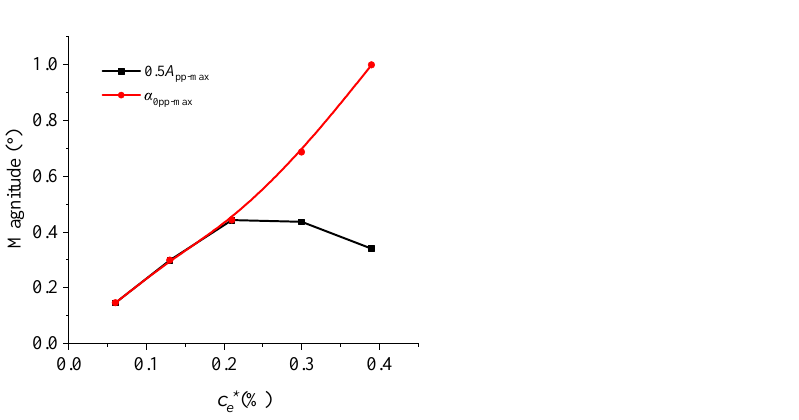
Figure 16. Half of the peak-to-peak value and average opening of the fluctuating cycle T pp-max as a function of end wall